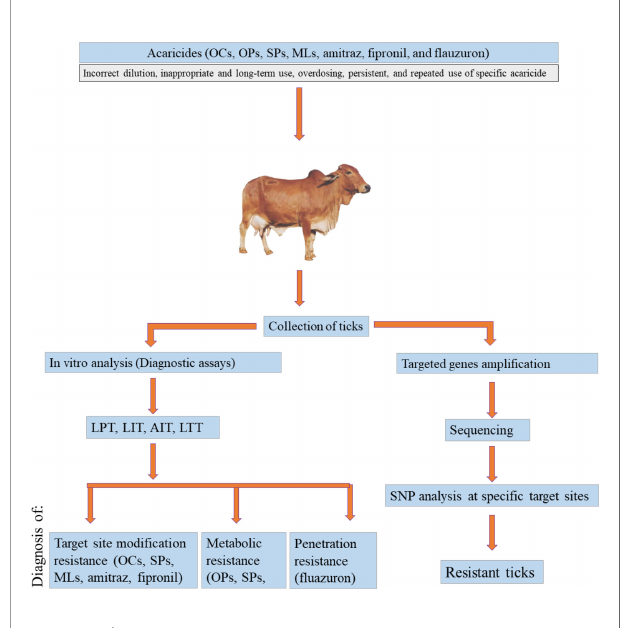
FIGURE 1 | Flow chart of tick resistance